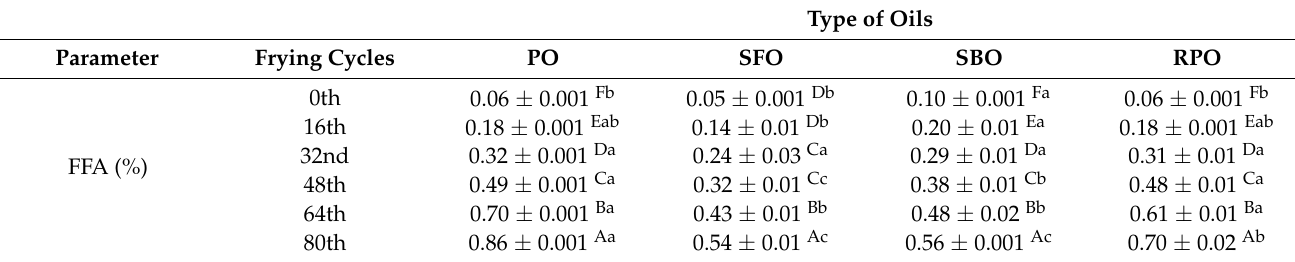
Table 2. Free fatty acid (FFA) percentages of different vegetable oils across 80 frying